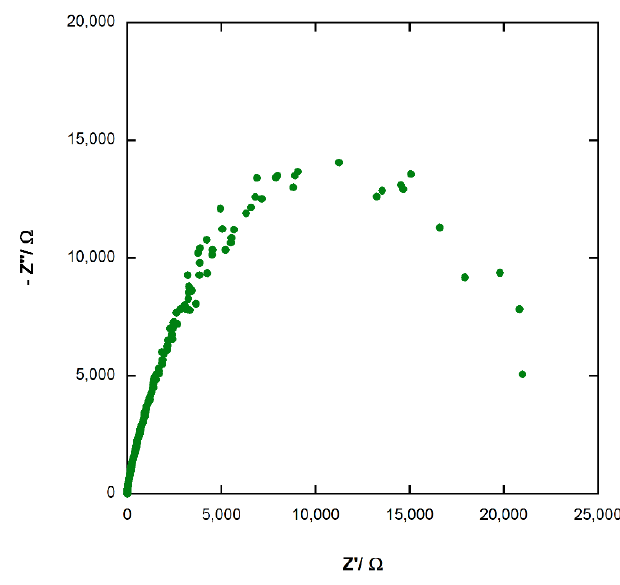
Figure 12. Nyquist plot of photoelectrochemical cell.